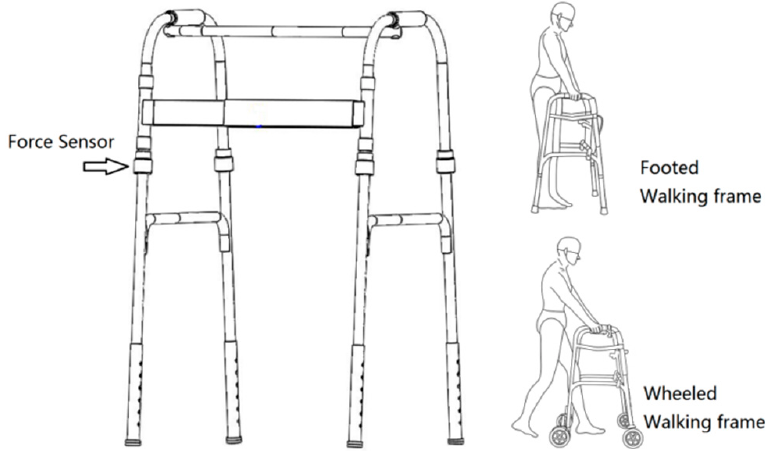
Figure 3. Two types of walking frames used for the experiment.